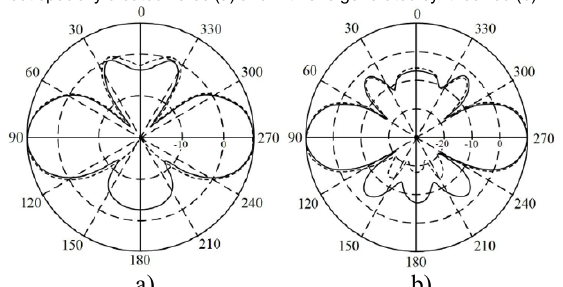
FIGURE 2. Normalized radiation patterns of antenna arrays of N = 5 (a) and N = 7 elements (b) without specially created zeros (solid lines) and with zeros formed according to criterion